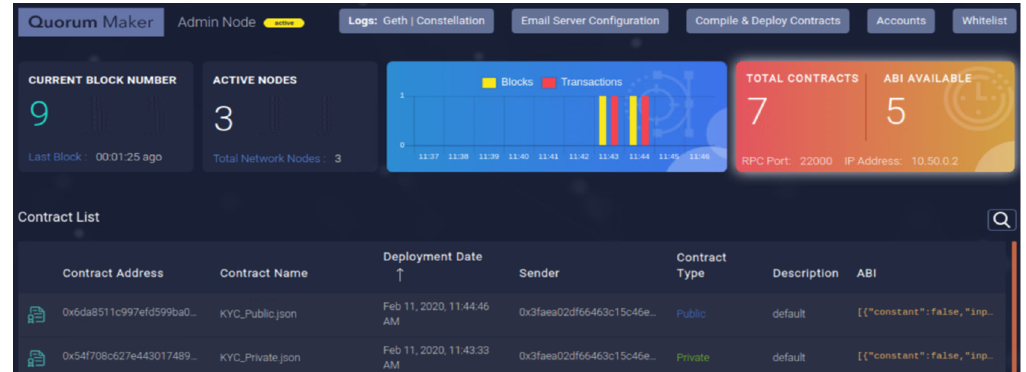
Figure 5. The public “KYC Smart Contract” and the private “KYC Admin Smart Contract” deployed on the Alastria Network through the Quorum Maker Utility [30] (to monitor smart contracts).